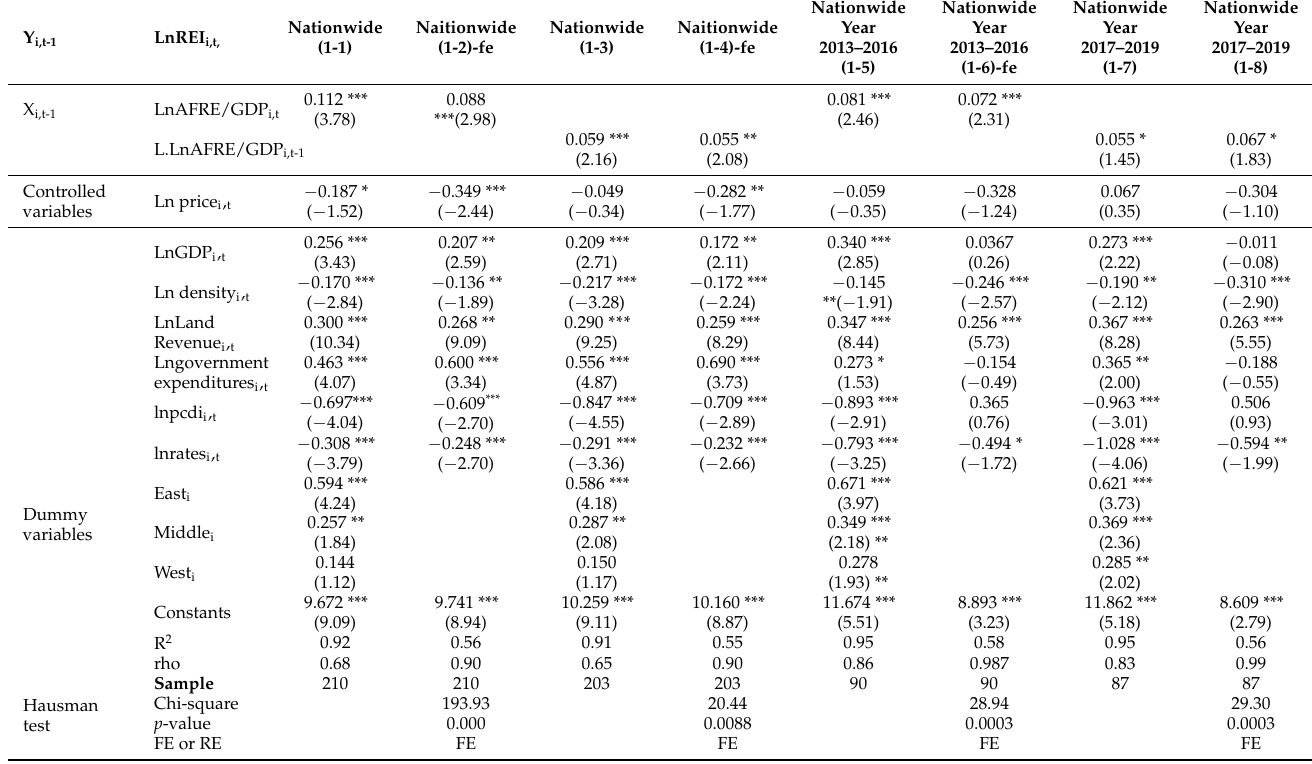
Table 3. Estimation results